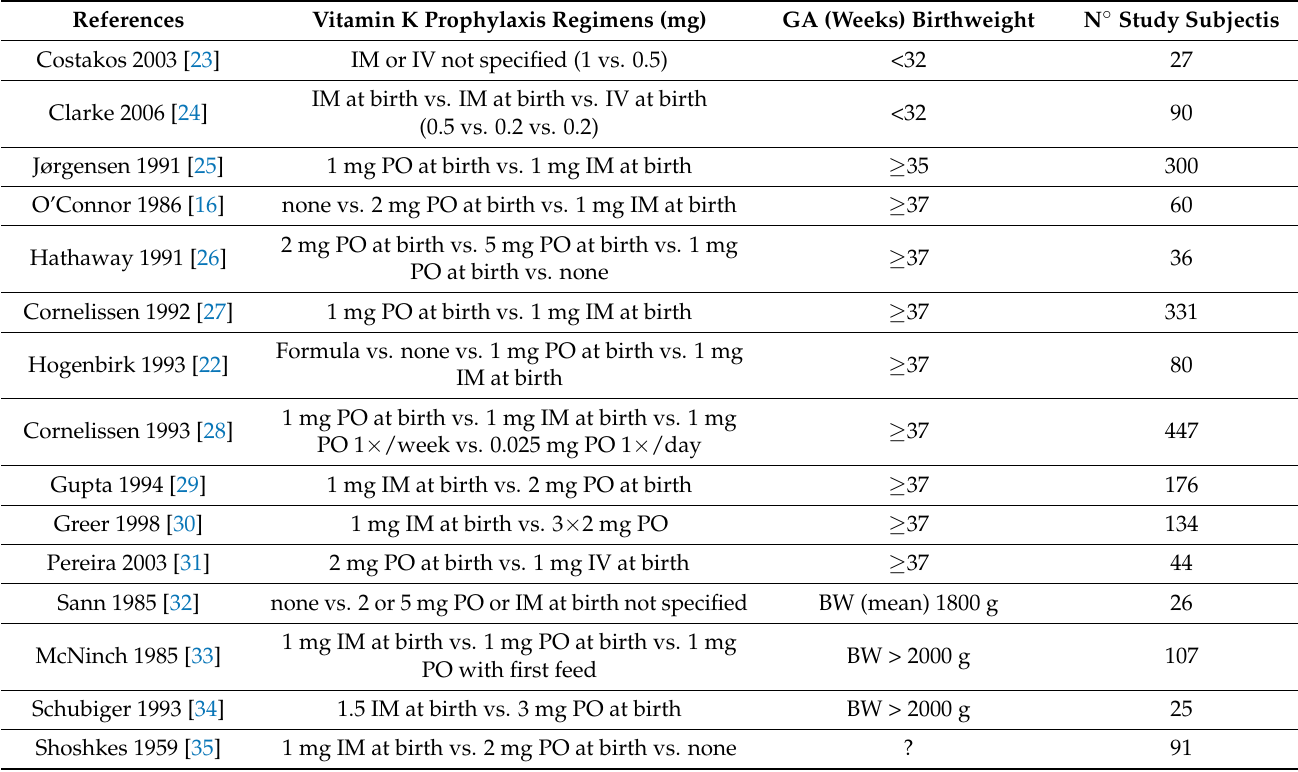
Table 1. Summary of included clinical trials in the literature